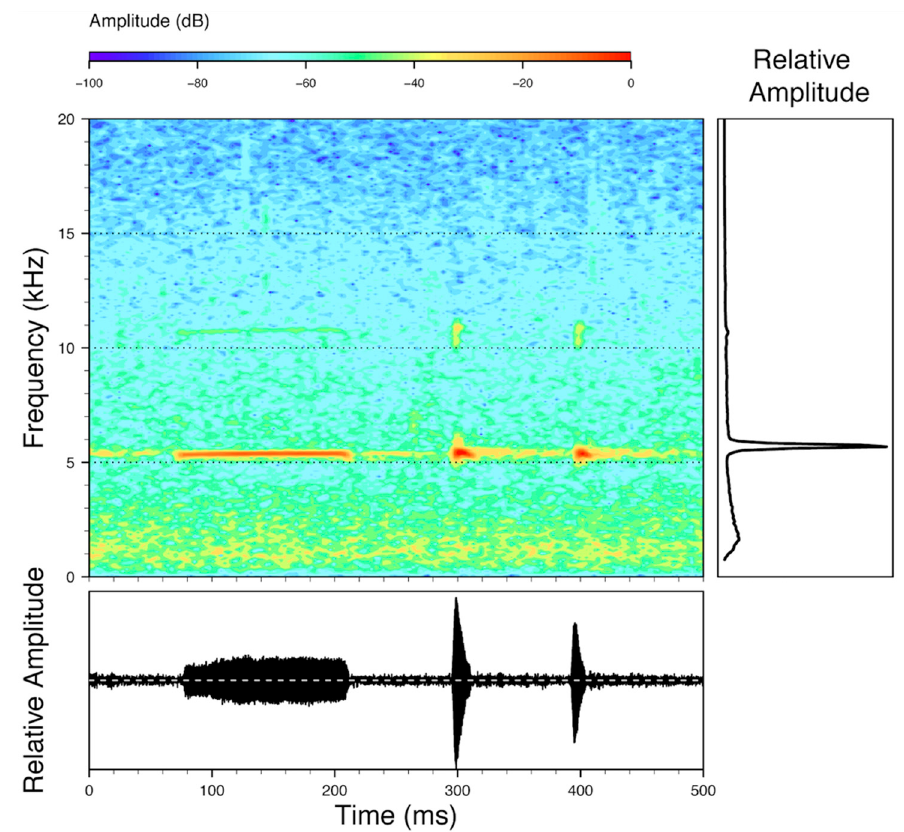
Figure 45. Call of Centrolene lynchi (LBE-C-013) recorded at Reserva Las Gralarias, 1822 m, Pichincha province, Ecuador.